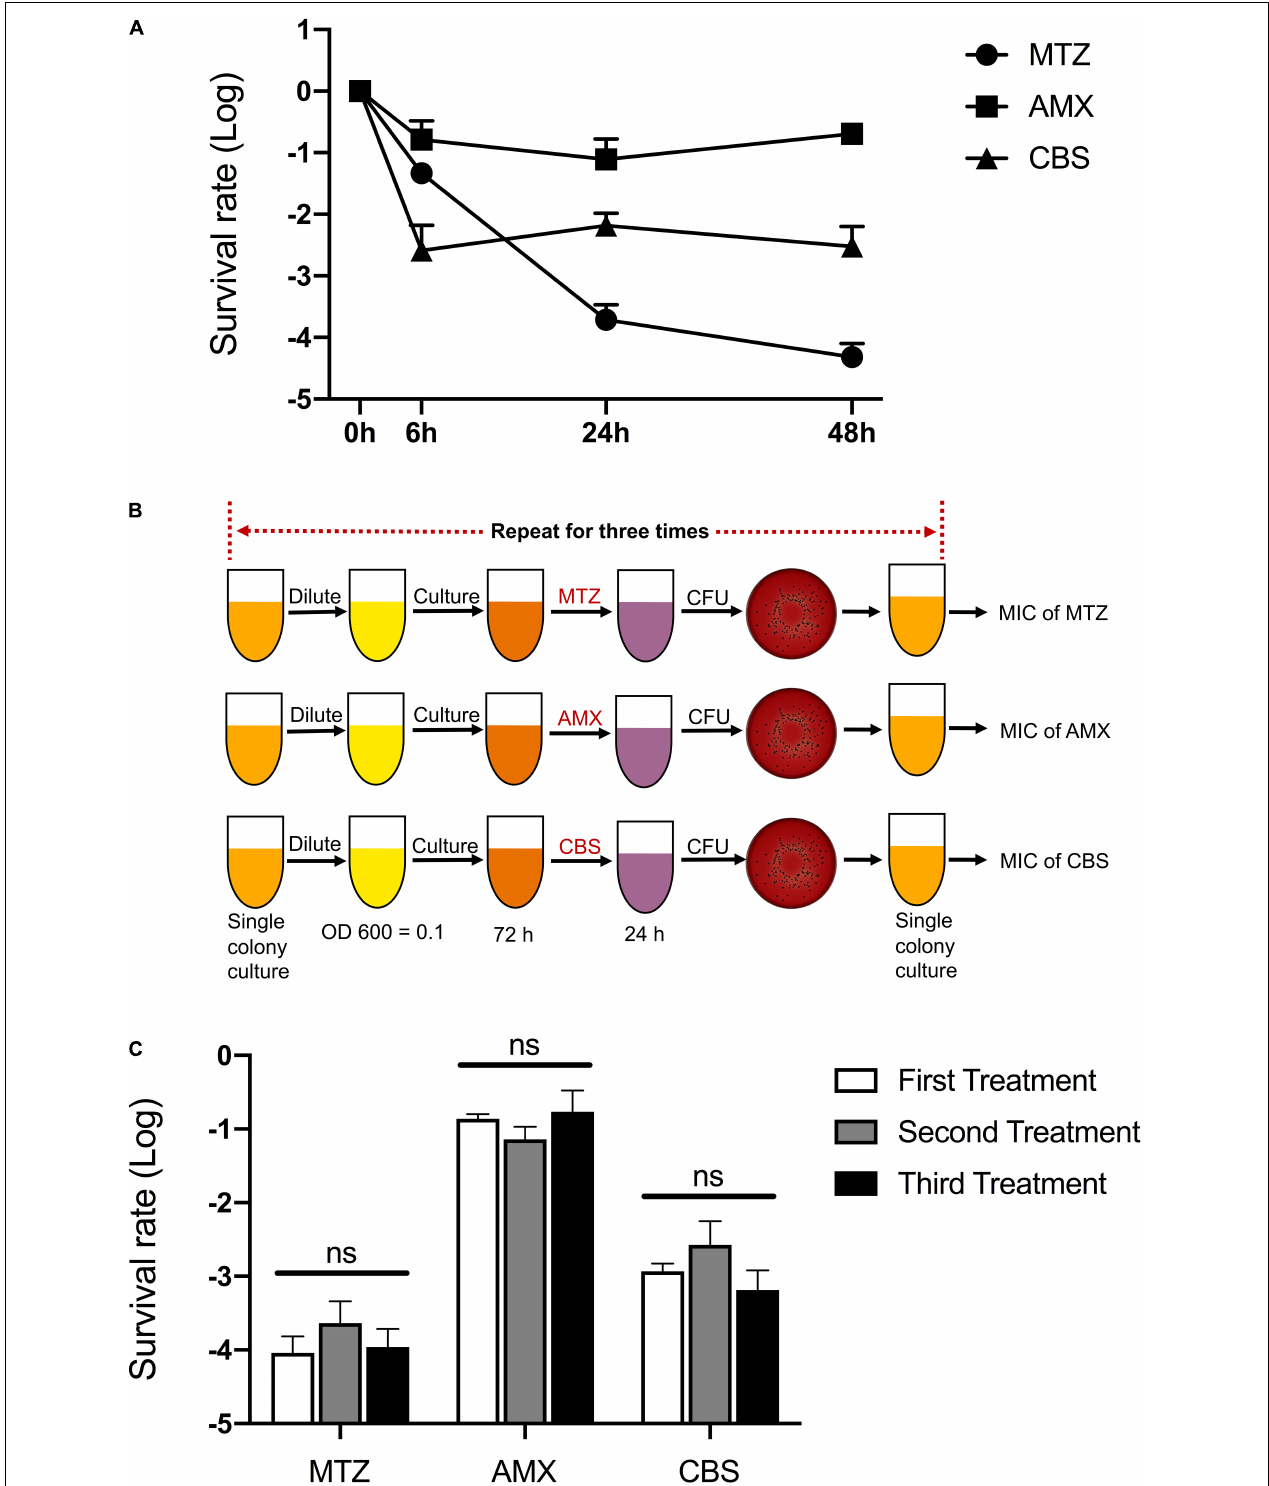
FIGURE 1 | Multiple antimicrobial tolerance of P. gingivalis persisters. (A) The biphasic killing curves of P. gingivalis persisters after treatments with metronidazole (MTZ, 100 mg/L), Amoxicillin (AMX, 100 mg/L), and colloidal bismuth subcitrate (CBS, 100 µ M) for 48 h, respectively. (B) Workflow of the three repeated treatments by MTZ, AMX, and CBS. (C) The survival rate of P. gingivalis persisters following the three repeated treatments by MTZ, AMX, and CBS. Data present the mean ± standard deviation (SD) of the results from three independent experiments. ns: no significance.